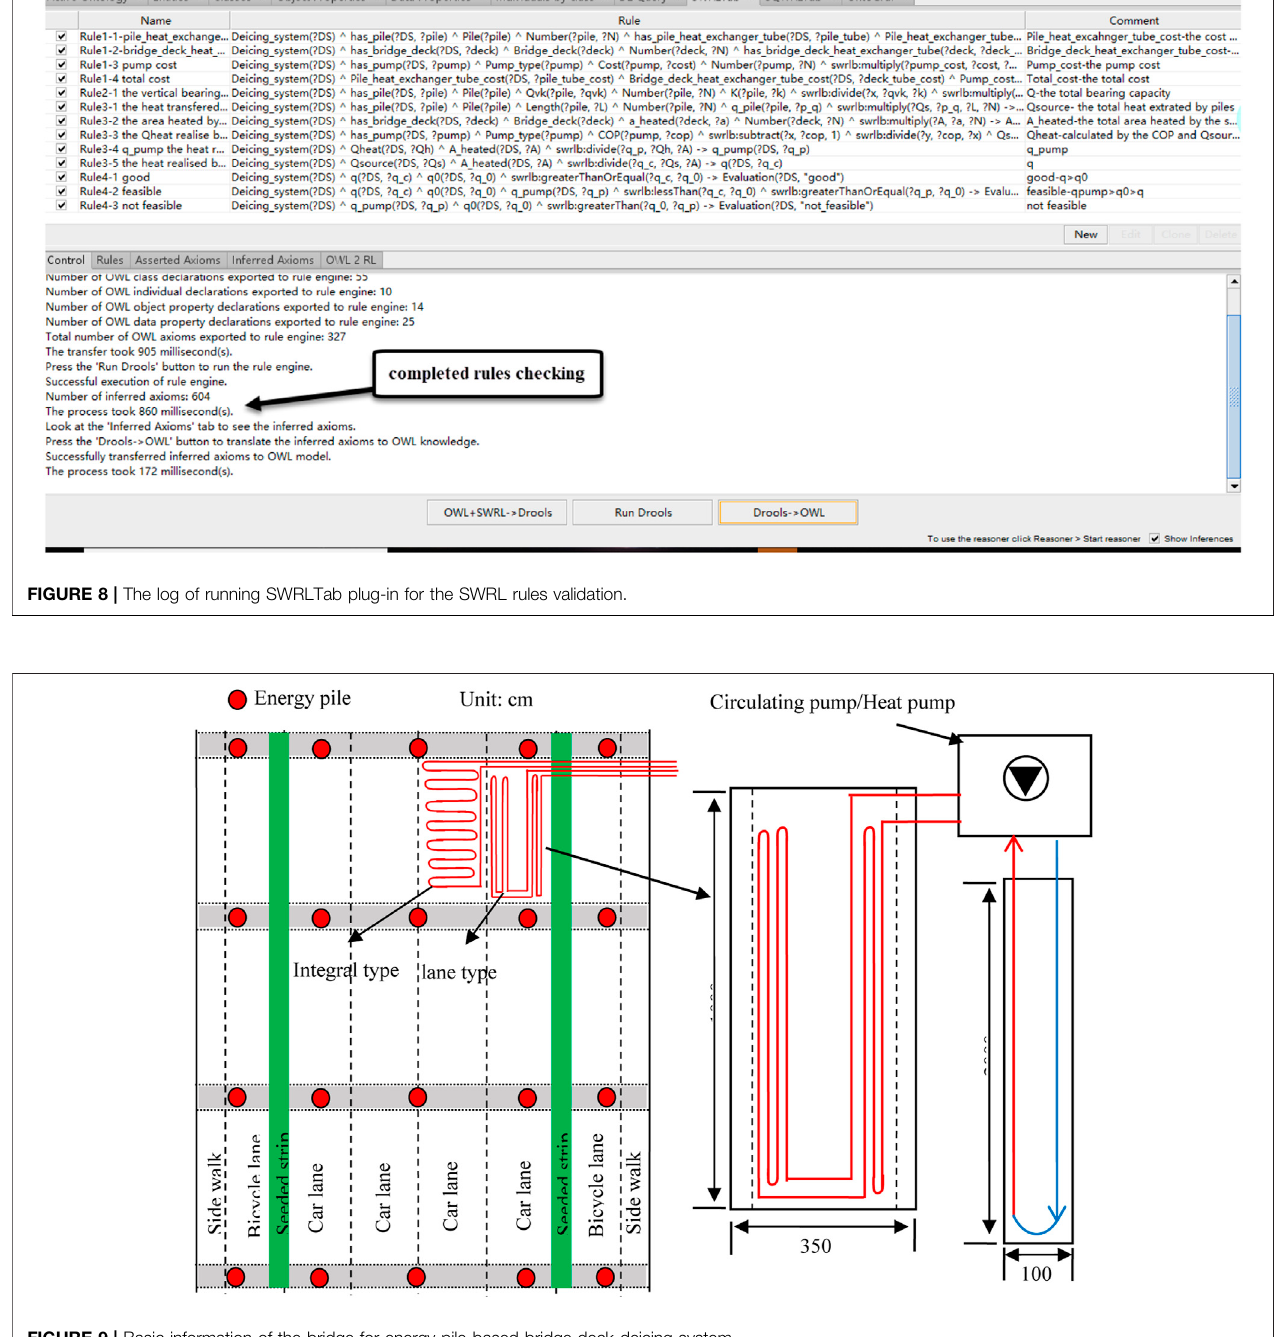
Frontiers in Materials |